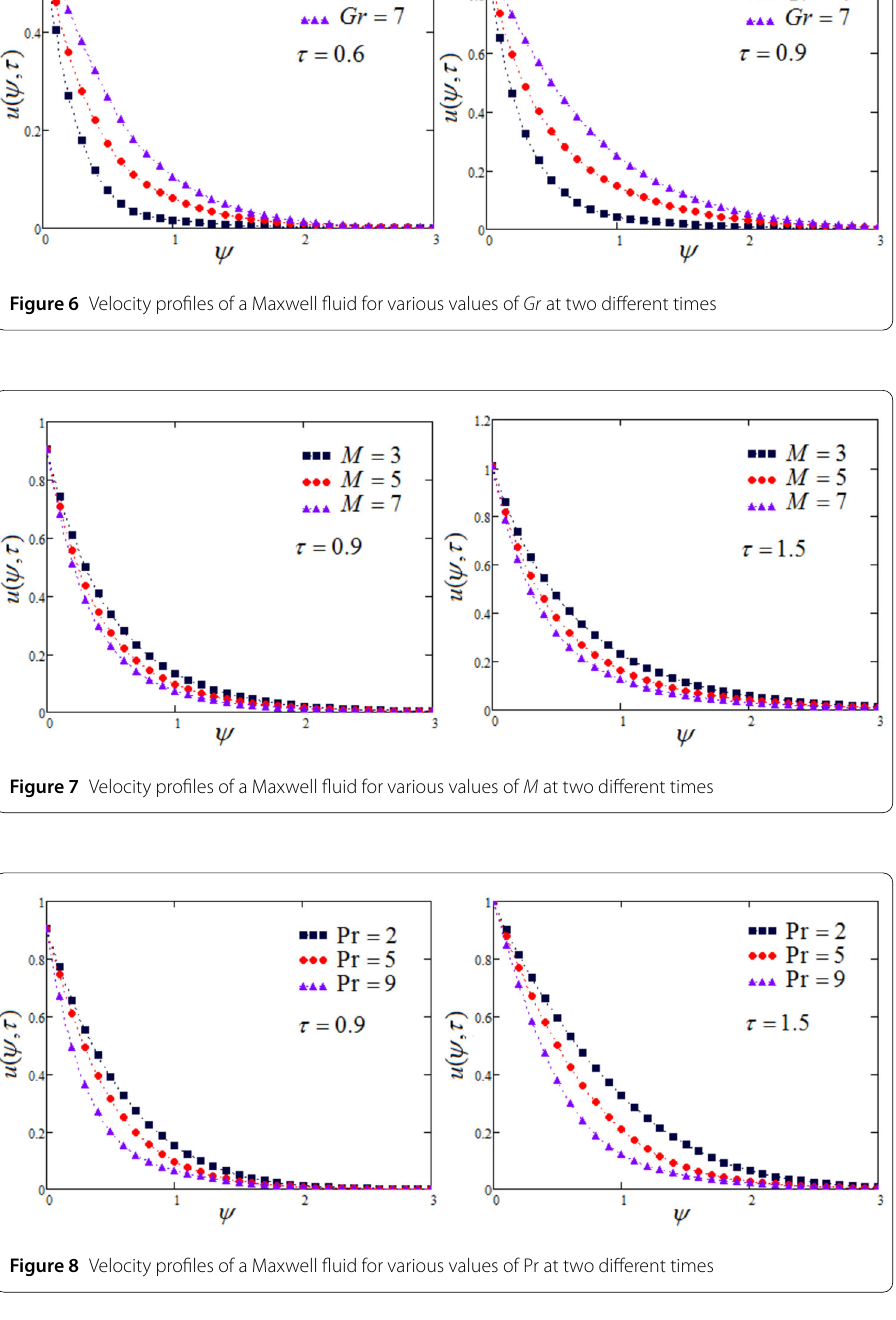
Hence, increasing the value of Pr improves the boundary thickness, which causes the en- ergy profile to slow down